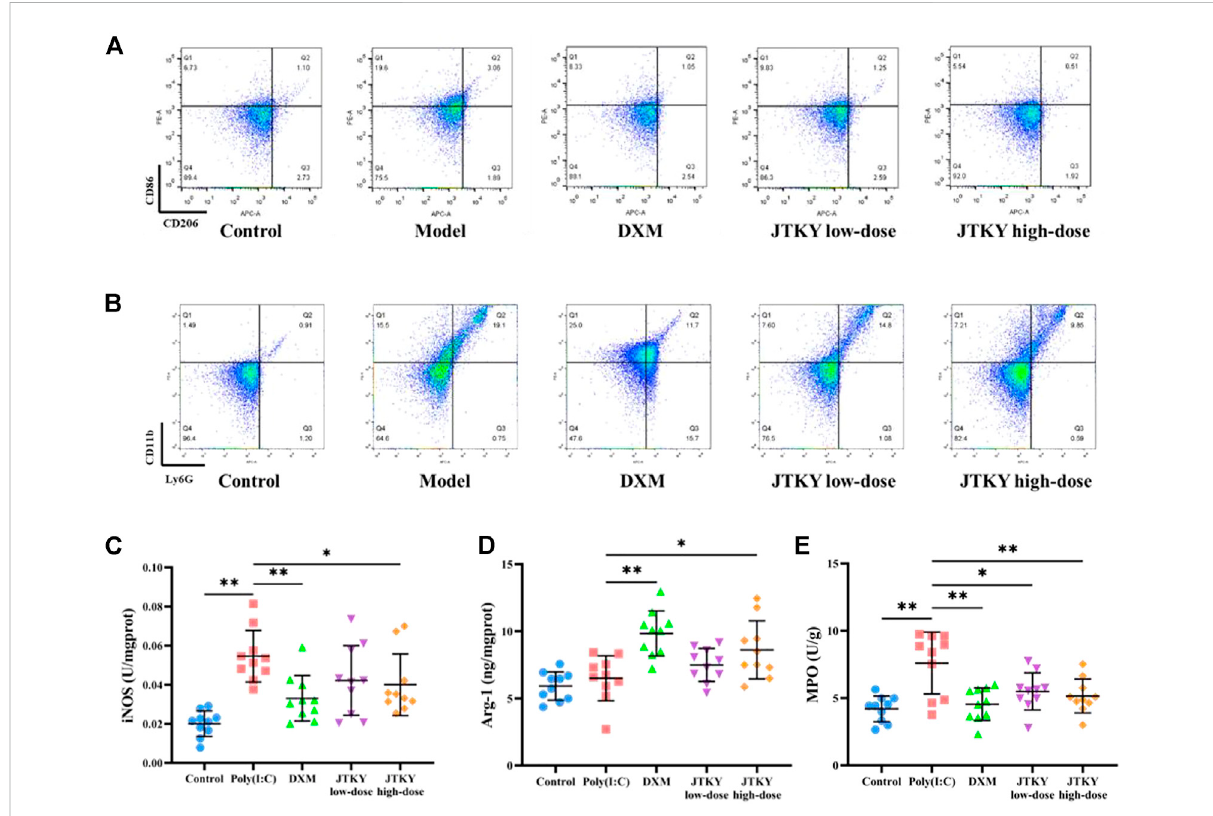
FIGURE 3 JTKY treatment affected the polarization of macrophage and inhibited the in fi ltration of neutrophils in lung. (A) Flow cytometry showed that JTKYtreatmentdecreasedtheratiobetweenCD86 + andCD206 + cells (A) andtheproportionofLy6G + CD11b + cells (B) inBALF. (C,D) JTKYtreatment decreased the activity of iNOS (C) and increased the level of Arg-1 (D) in lung tissue homogenates. (E) JTKY treatment decreased the activity of MPO in lung tissue homogenates. Control, poly(I:C), DXM, JTKY low-dose and JTKY high-dose groups ( n = 10 per group). *: p < 0.05; **: p < 0.01.